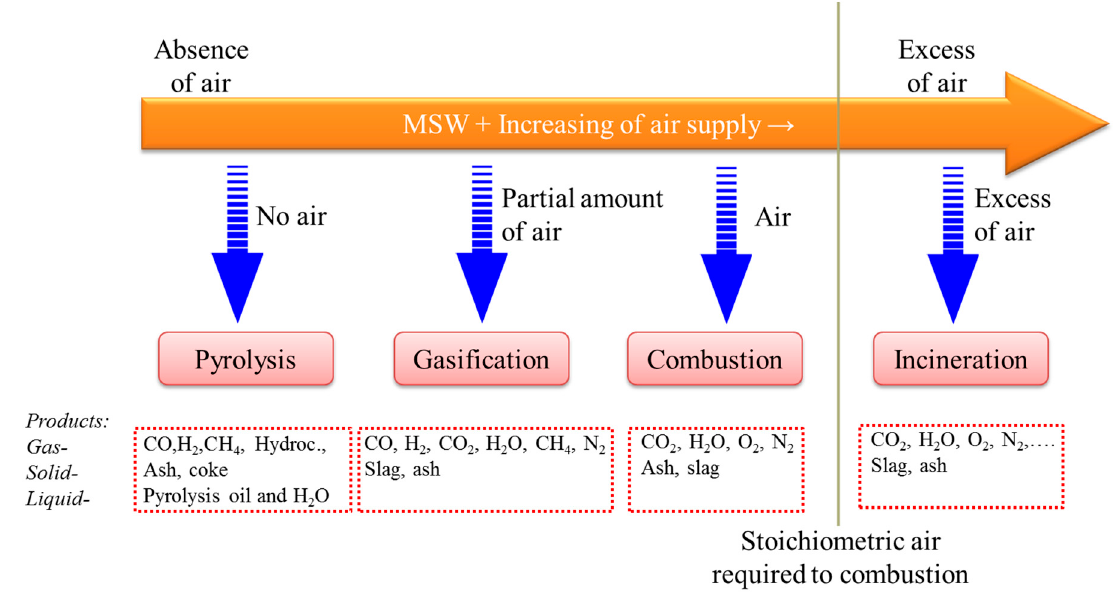
Figure 3. Main characteristics of chemical processes for thermal treatment of MSW.